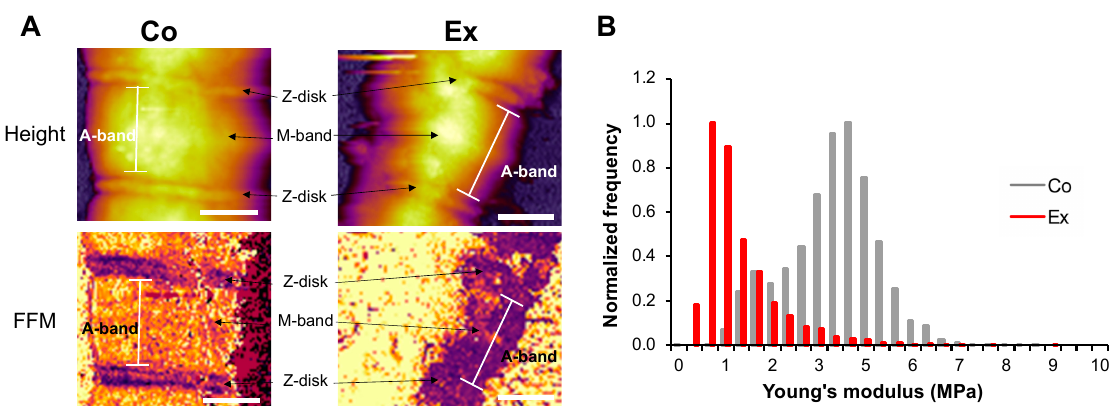
Figure 4. Fast force mapping of sarcomeres with AFM. ( A ) Height image and stiffness map of a Co and Ex sarcomere at a trigger force of 500 pN. ( B ) The Young’s modulus is decreased in the Ex group vs. Co. Young’s modulus was calculated with the Johnson ‐ Kendall ‐ Roberts (JKR) fitting model. Note that the Ex sarcomere showed more perturbation. Scale bar = 1 μ m.